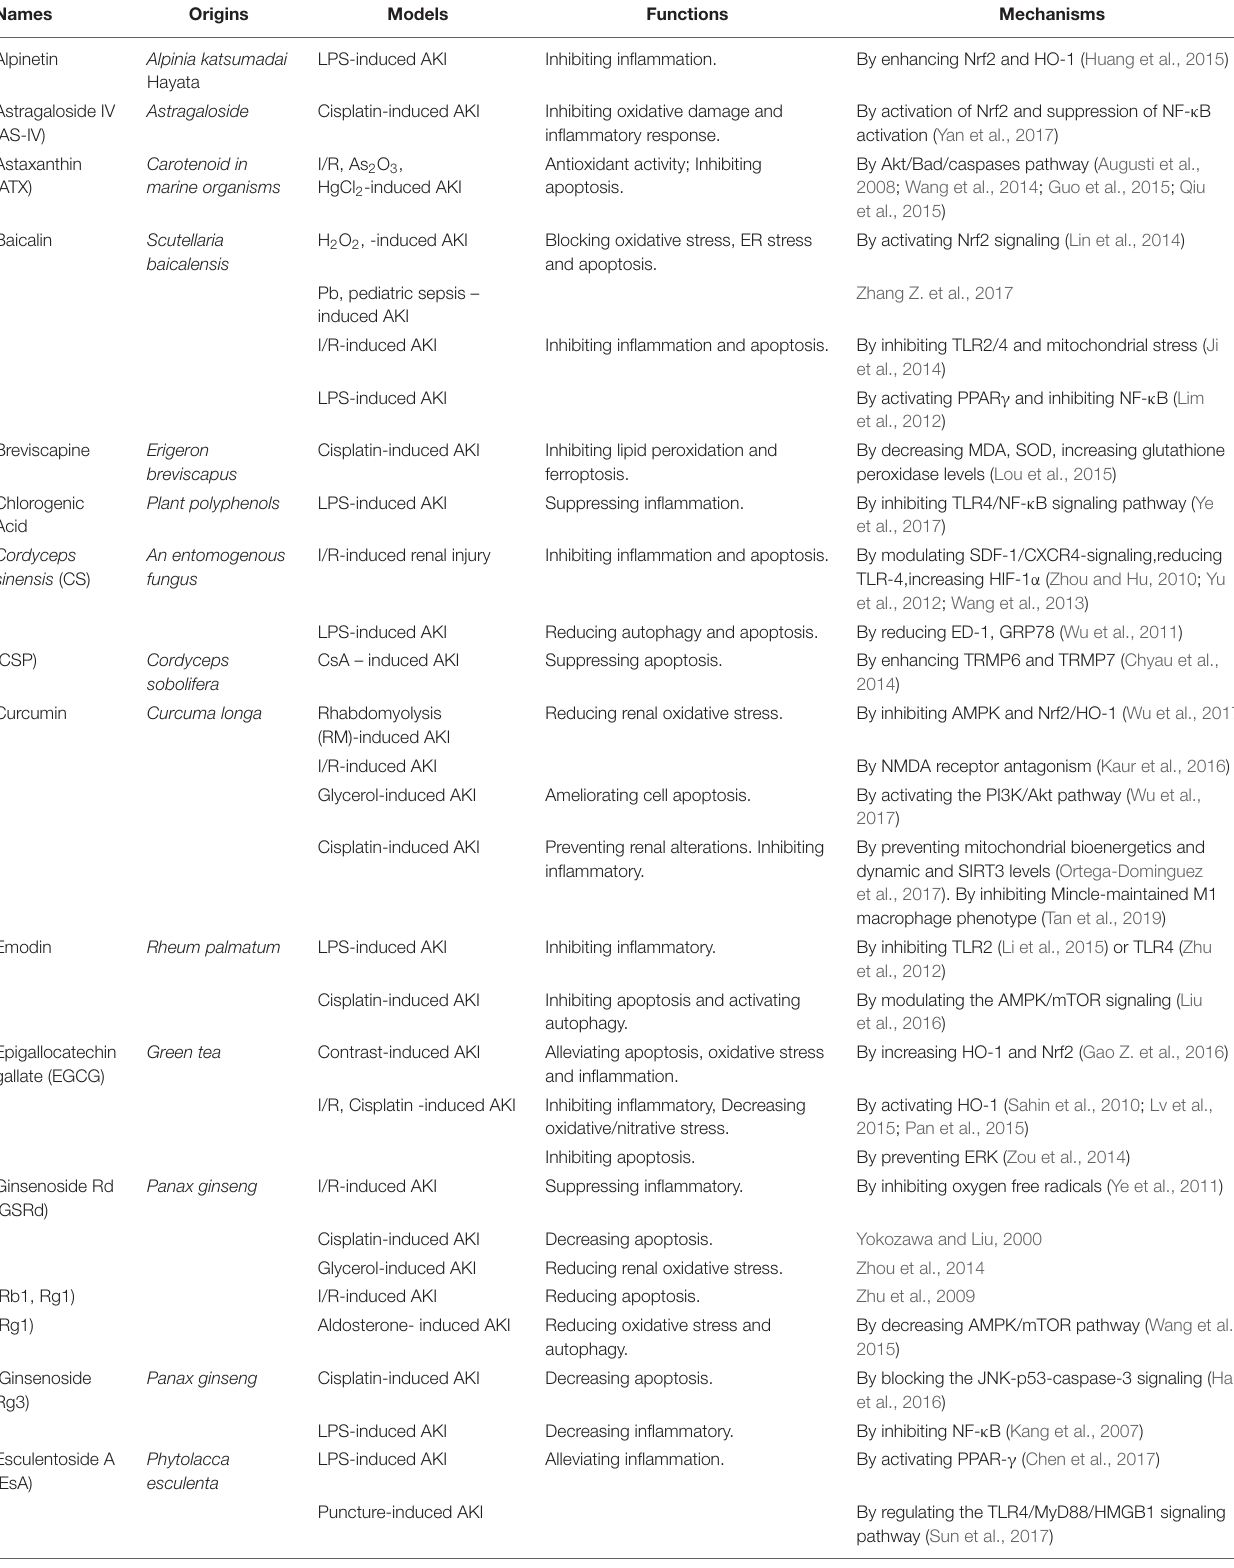
TABLE 2 | Application of TCM monomers in the treatment of acute kidney